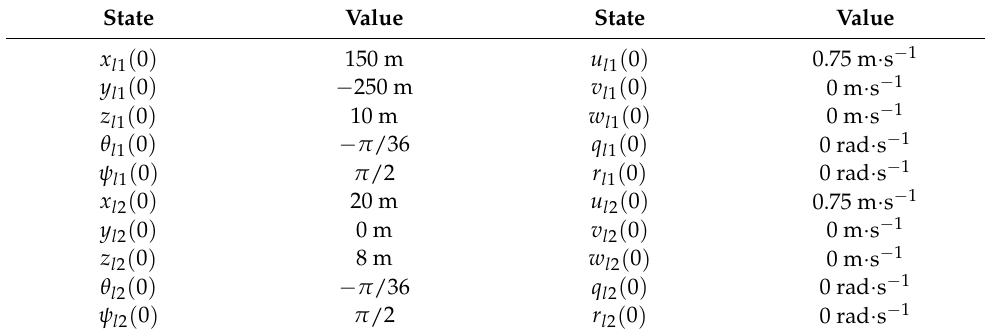
Table 2. The leaders’ initial